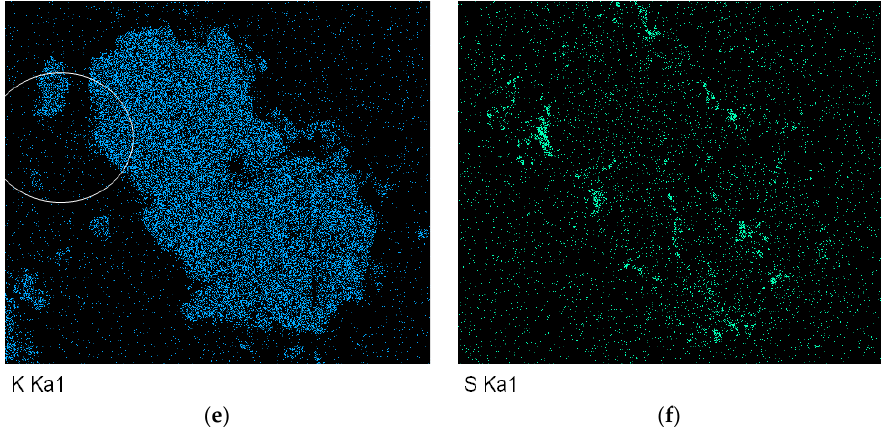
Figure 7. Morphology and element distribution of muscovite in leached quartz sand: leaching conditions (0.025 mol/L H 2 SO 4 , 0.050 mol/L NH 4 Cl, 5 mL/g of L/S ratio, 250 °C); G—“gulf”, DF—directional fracture, IL—internal layer, SL—surface layer, and SD—surface damage: ( a ) component image, ( b ) morphology image, ( c ) distribution of Si, ( d ) distribution of Al, ( e ) distribution of K, ( f ) distribution of S.